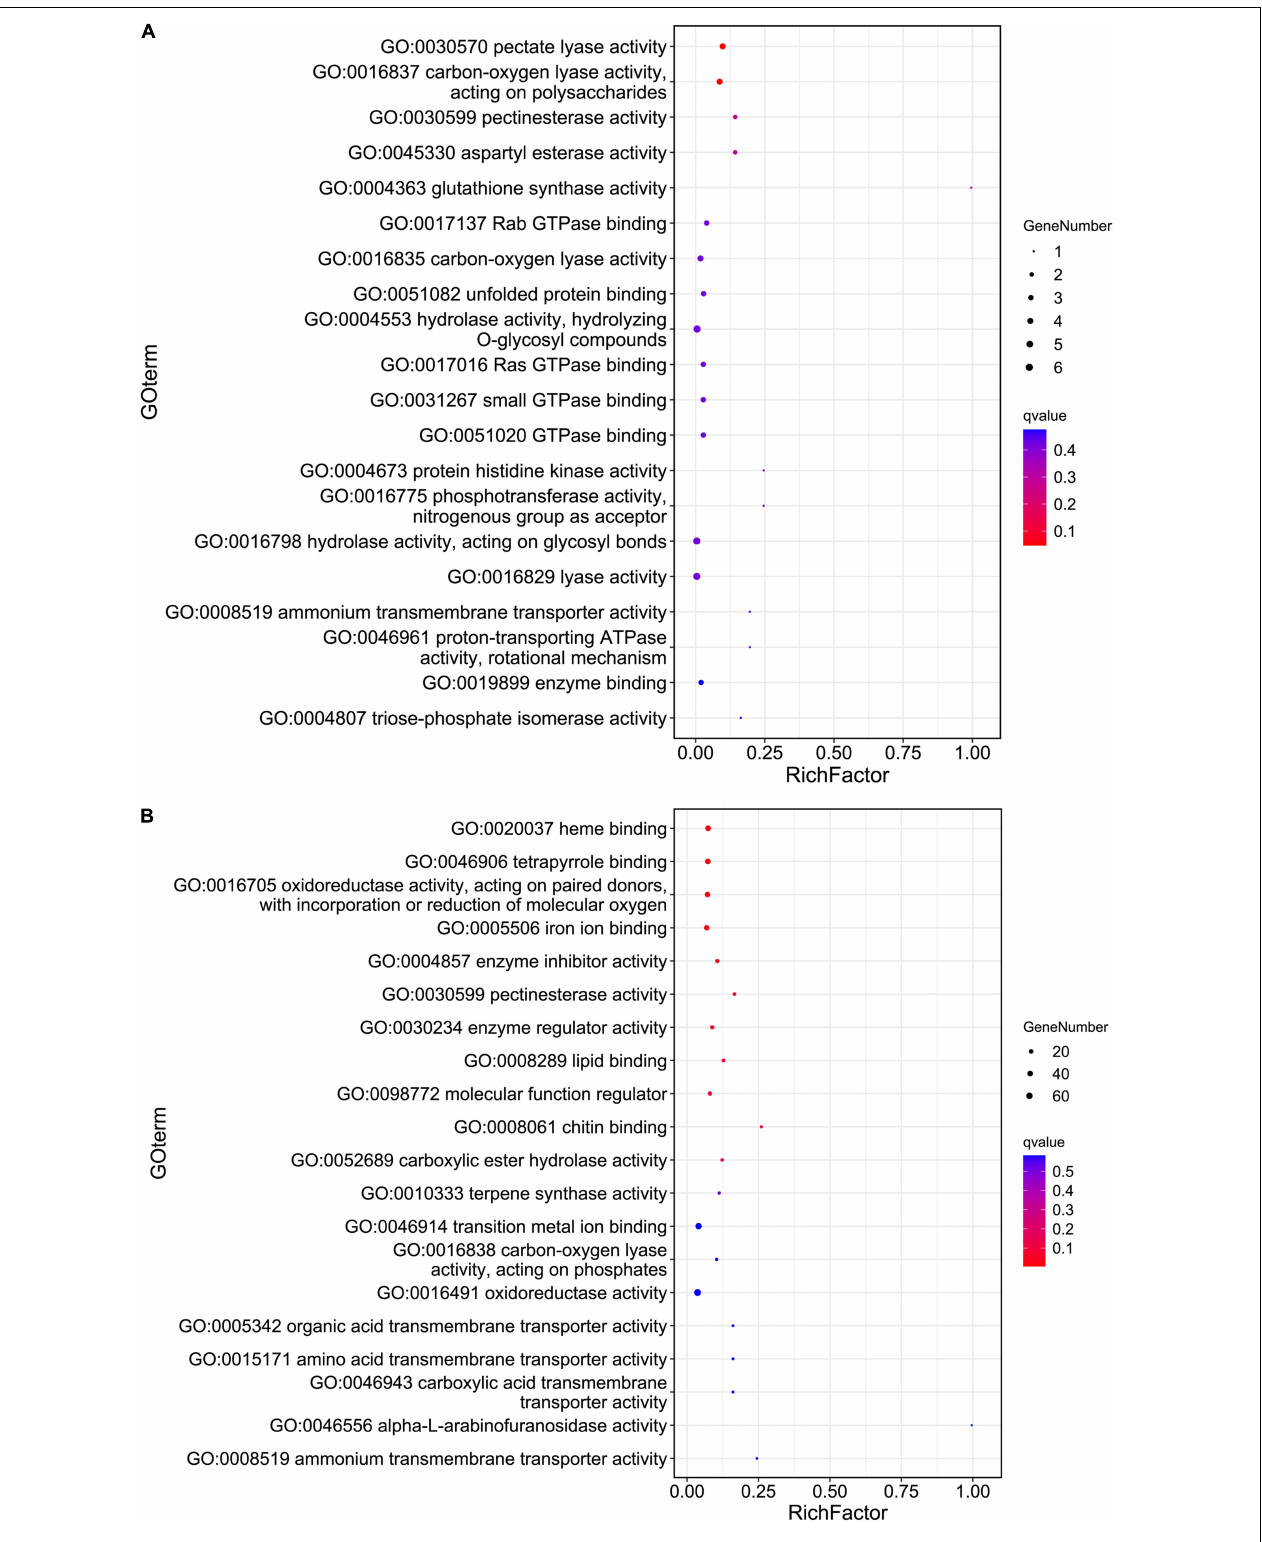
FIGURE 2 | The Gene Ontology (GO) enrichment of the pathogen specifically expressed genes (SEGs) (A) and potato SEGs (B) identified from compatible interaction. Hypergeometric tests were performed with a threshold value of false discovery rate (FDR) < 0.05 based on the GO classification of 224 pathogen (A) and 1,312 potato (B)